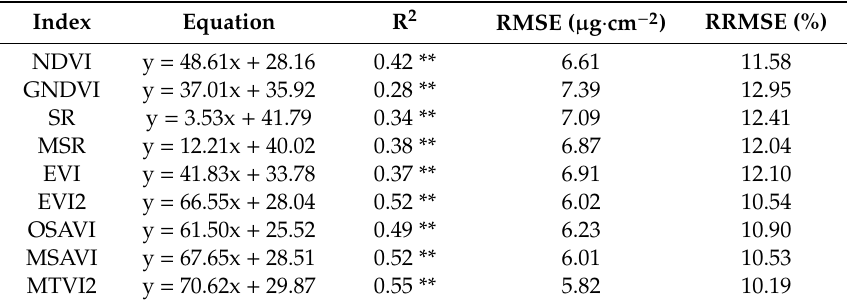
Table 6. Calibration results of VIs for LCC assessment.